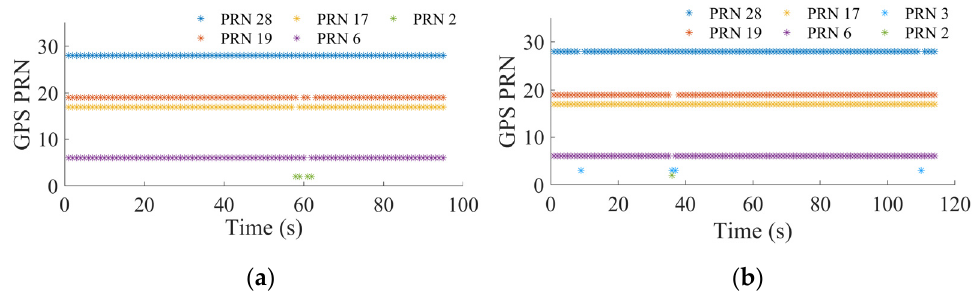
Figure 17. Time series of selected GPS PRN when 4 satellites are visible. ( a ) Clockwise. ( b ) Coun-